Question: Is the quantity shown trending increasing or decreasing?
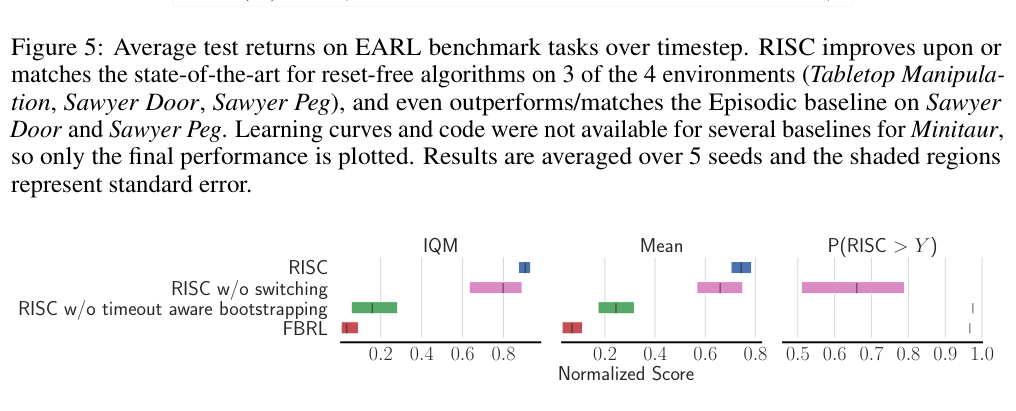
Answer: increasing